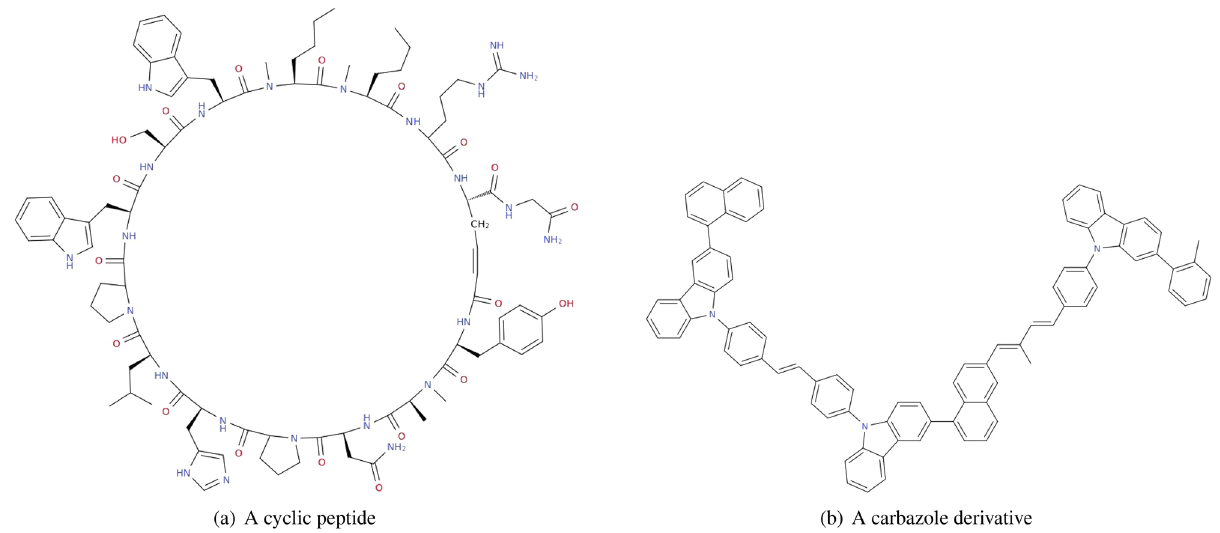
Figure 9. Two examples of challenging molecules for which Transformer generates correct